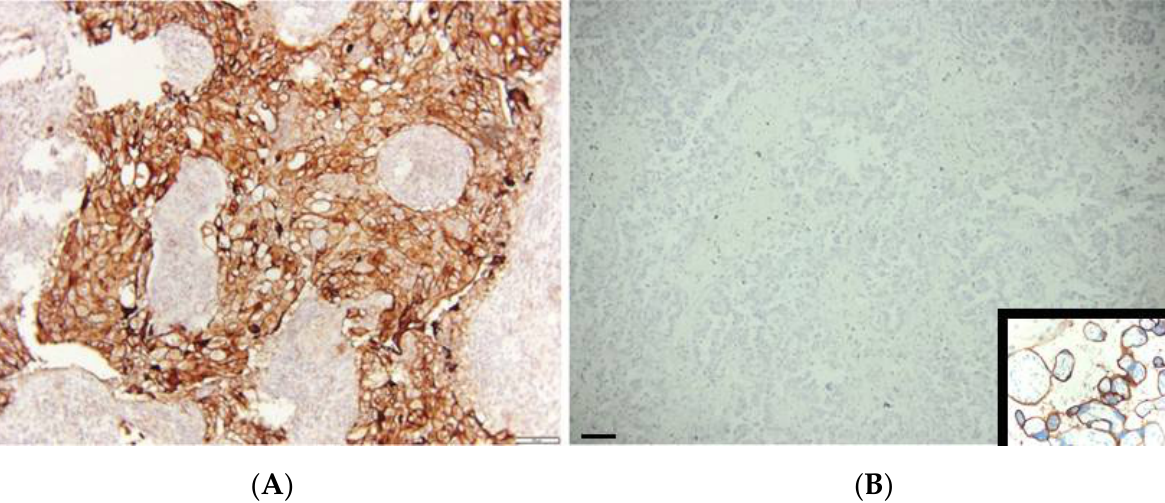
Figure 1. PD-L1 expression in cancer cells of NSCLC ( A ) strongly positive and ( B ) completely negative. The inset on panel B represents the PD-L1 positive trophoblast cells in placental villi. Scale bar 25 µm. IMR was analysed on middle-power magnification fields (200 × ) on the original HE slides of the primary cancer (the centre and the margin). According to the number of immune cells (few, mild, or high) and the pattern of tumour stroma (desmoplastic or sparse), IMR was qualified as absent (few immune cells in the desmoplastic stroma), low (mild number of immune cells in the broad front to clusters of tumour cells in the desmoplastic stroma), and strong (very dense infiltration of immune cells mixed with the tumour in the sparse stroma) (Figure 2).